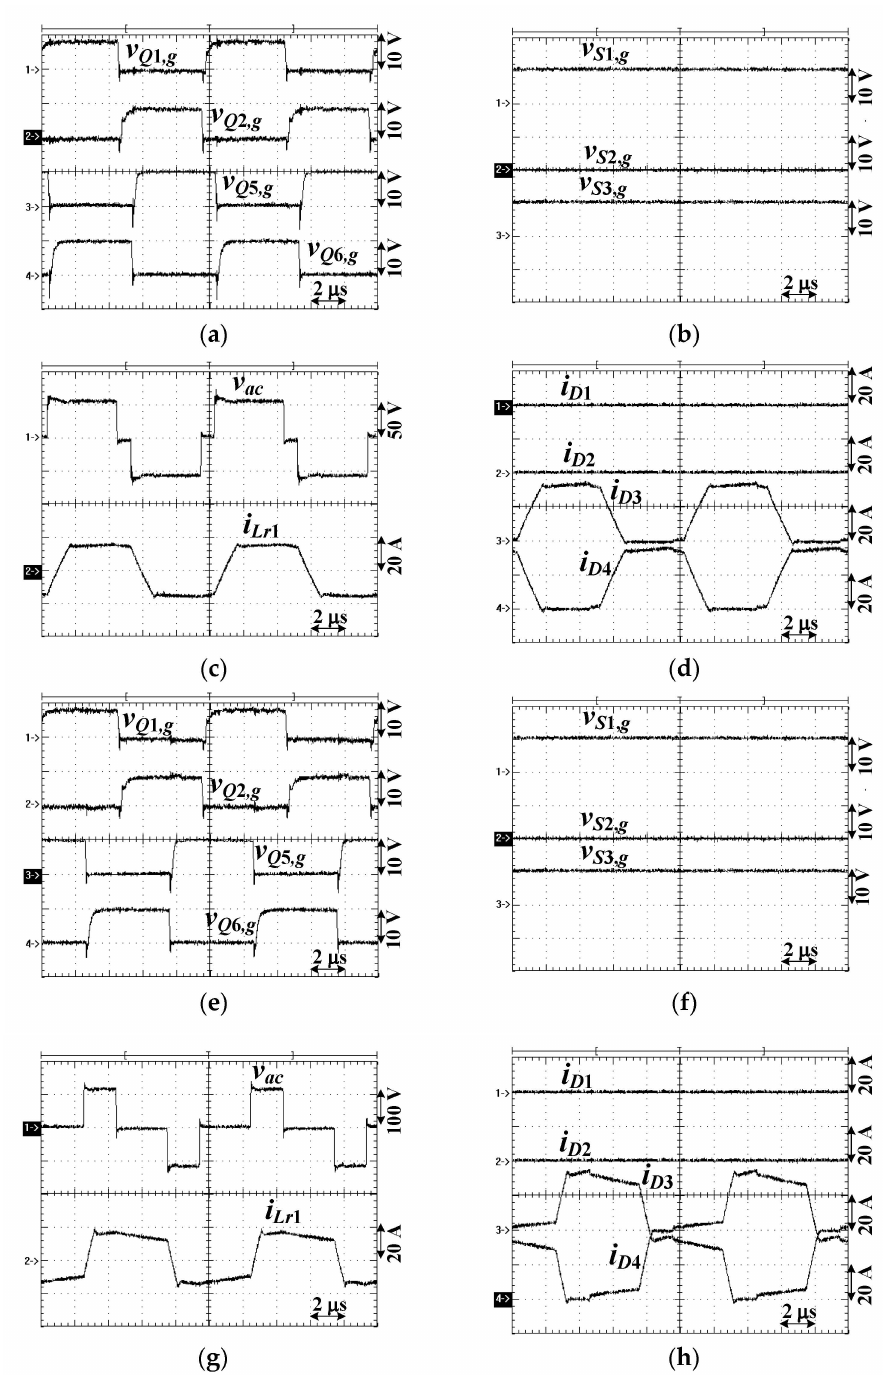
Figure 8. Experimental waveforms under medium input voltage range and full load: ( a ) switch waveforms v Q 1 ,g , v Q 2 ,g , v Q 5 ,g , and v Q 6 ,g at V in = 57 V, ( b ) AC switch waveforms v S 1 ,g ~ v S 3 ,g at V in = 57 V, ( c ) v ab and i Lr 1 at V in = 57 V, ( d ) i D 1 ~ i D 4 at V in = 57 V, ( e ) switch waveforms v Q 1 ,g , v Q 2 ,g , v Q 5 ,g , and v Q 6 ,g at V in = 123 V, ( f ) AC switch waveforms v S 1 ,g ~ v S 3 ,g at V in = 123 V, ( g ) v ab and i Lr 1 at V in = 123 V, and ( h ) i D 1 ~ i D 4 at V in = 123